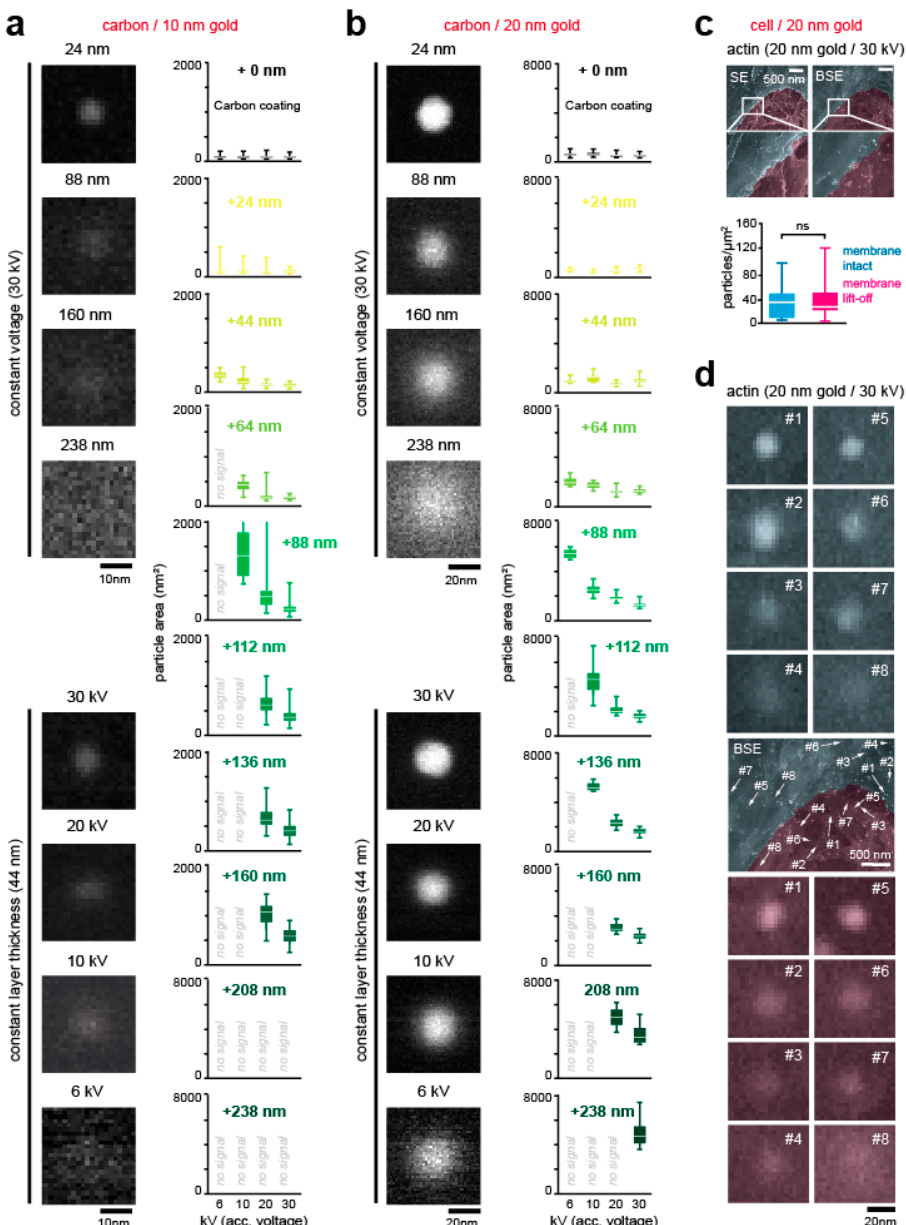
Figure 2. Validation of gold particle detection accuracy. ( a , b ) Detection of 10 nm ( a ) and 20 nm ( b ) gold particles through carbon layer via BSE detector. To the left, images of gold particles acquired at 50,000× magnification (1.45 nm per pixel), with an acceleration voltage of 30 kV. Samples were imaged with constant acceleration voltage and varying layer thickness ( top ) as well as with varying acceleration thickness and constant layer thickness ( bottom ). To the right, analysis of the scattering area. From top to bottom, gold particles were deposited on an EM grid (0 nm) and coated with increasingly thick carbon layers. For each thickness, acceleration voltages of 6 kV, 10 kV, 20 kV, and 30 kV were applied. Boxplots depict the scattering area of back-scattered electrons. (c) Partially unroofed cell samples. Samples were prepared and labelled with a primary antibody directed against actin, as mentioned above. In some regions, weakly adhesive tape was used to partially unroof the cell (pink, membrane lift-off), and imaged in SE ( top ) and BSE ( bottom ) mode. Images of 20 nm gold particles were acquired at 25,000× magnification (2.89 nm per pixel), with an acceleration voltage of 30 kV. For statistical analysis, gold particles were counted in intact membrane areas (cyan) and compared to unroofed areas (pink) (intact membrane, n = 20 images; lift-off membrane, n = 11 images; t -test with Welch's correction p < 0.5969; Mann - Whitney test p = 0.6349). ( d ) BSE of